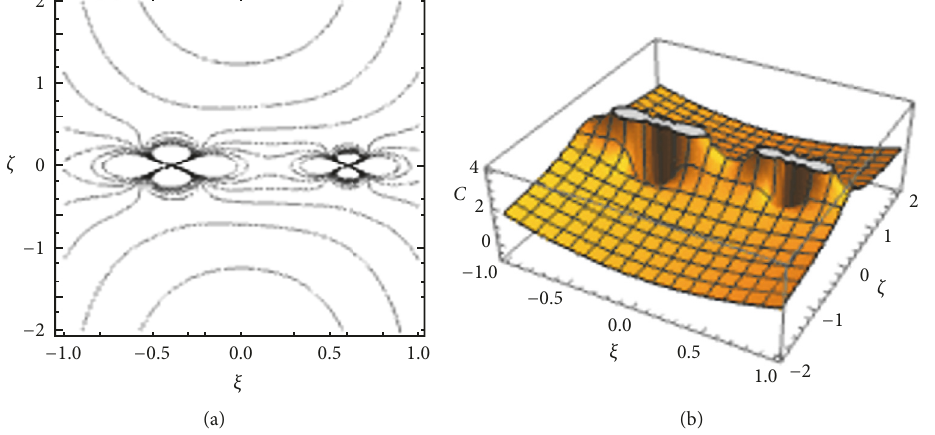
Figure 2: Zero-velocity curves in the ( 𝜉 − 𝜁 ) plane of PSR 1903+0327 for 𝐴 = 0.1,𝑎 = 0.95,𝜎 1 = 0.03 and 𝜎 2 = 0.015